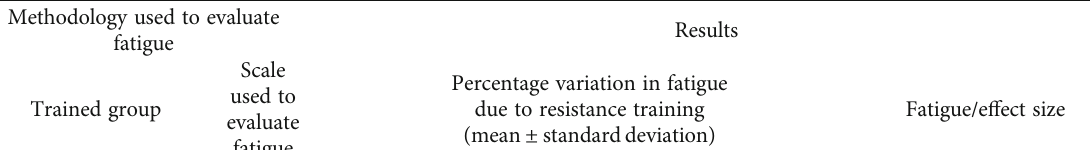
Table 2: E ff ects of muscle strength exercise on